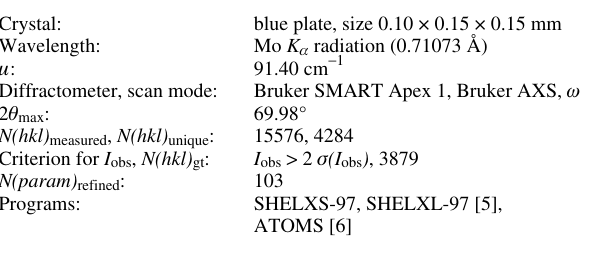
Table 1. Data collection and handling.